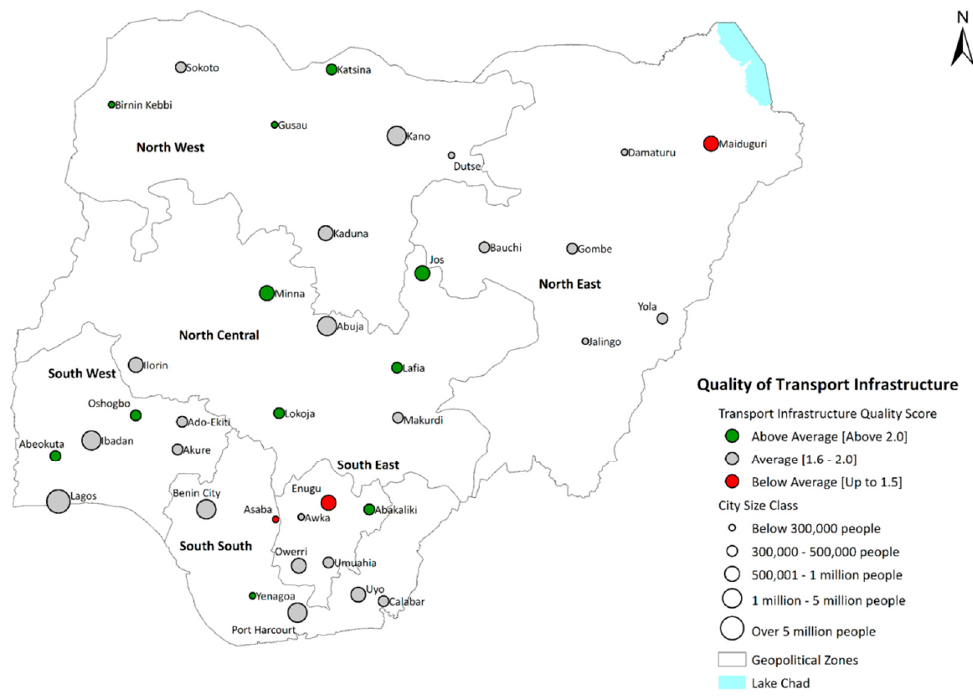
Figure 5. Quality of Transport Infrastructure 2007/2009.